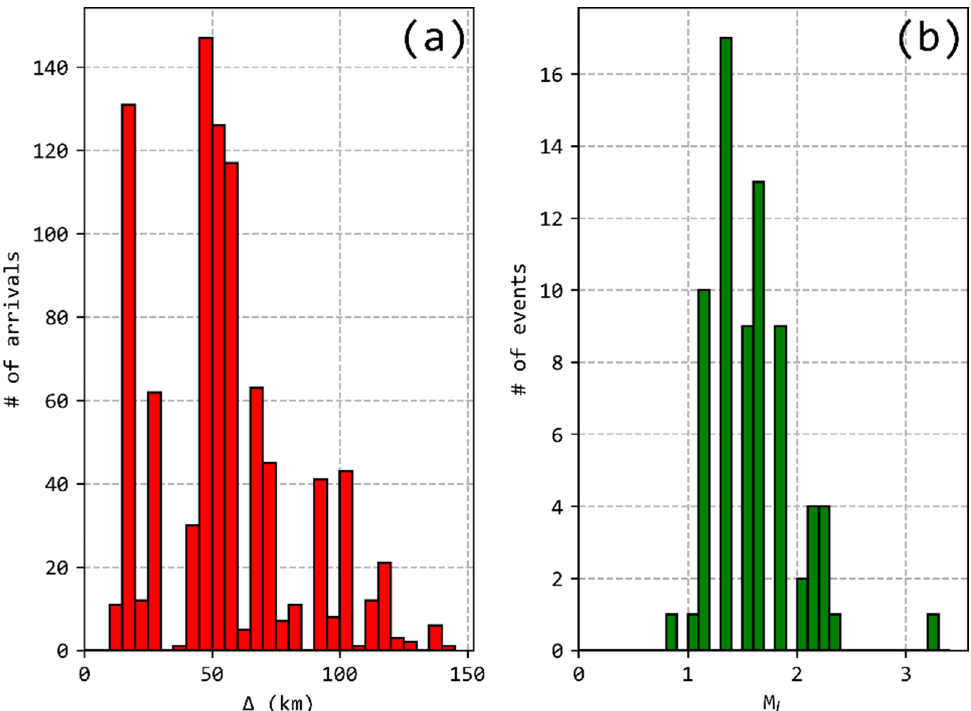
Figure A5. ( a ) Distribution of epicentral distances ( Δ ) for available arrivals and ( b ) histogram of M L for the aftershock sequence.